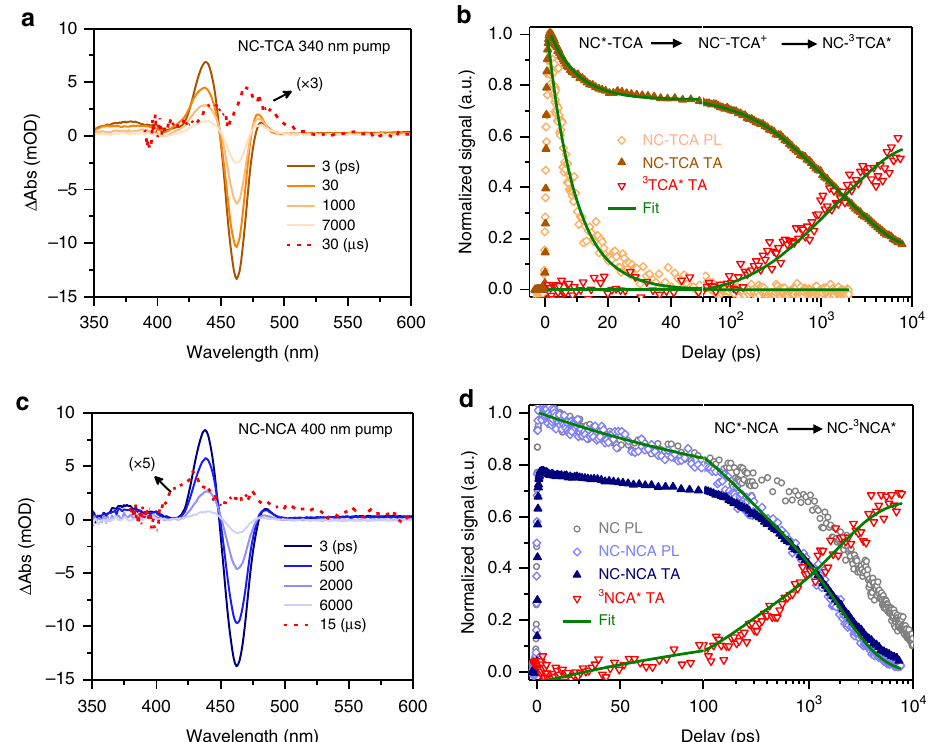
Fig. 5 TET dynamics in NC-PAH complexes. a TA spectra of NC-TCA complexes at indicated time delays following the excitation by a 340 nm pulse. The spectrum at 30 μ s is ampli fi ed by a factor of 3. b TA kinetics of NC-TCA complexes probed at the XB centre (~460 nm; dark orange solid triangles) and at the 3 TCA* (~485 nm; red open triangles) and TR-PL kinetics probed at the PL peak (~475 nm; light orange open diamonds). The green solid lines are their fi ts using a model described by the inset equation. Note that the fi rst 50 ps is plotted in linear scale and the rest in logarithmic scale. c , d Similar plots as ( a , b ) for NC-NCA complexes. The excitation wavelength is 400 nm and the 3 NCA* TA feature is probed at 415